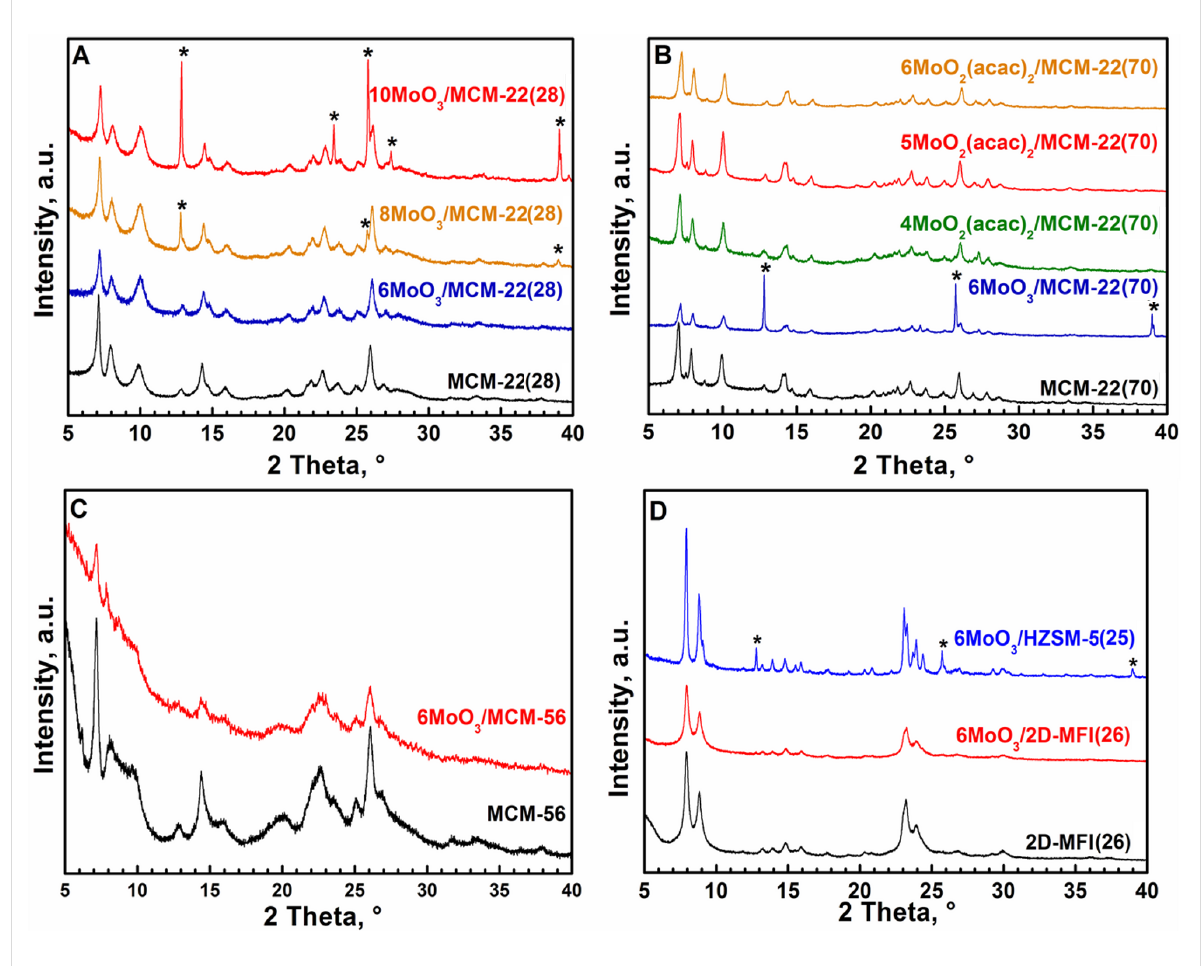
Figure 1: A,B,C,D: XRD patterns of parent supports and catalysts used. Asterisk marks MoO 3 .